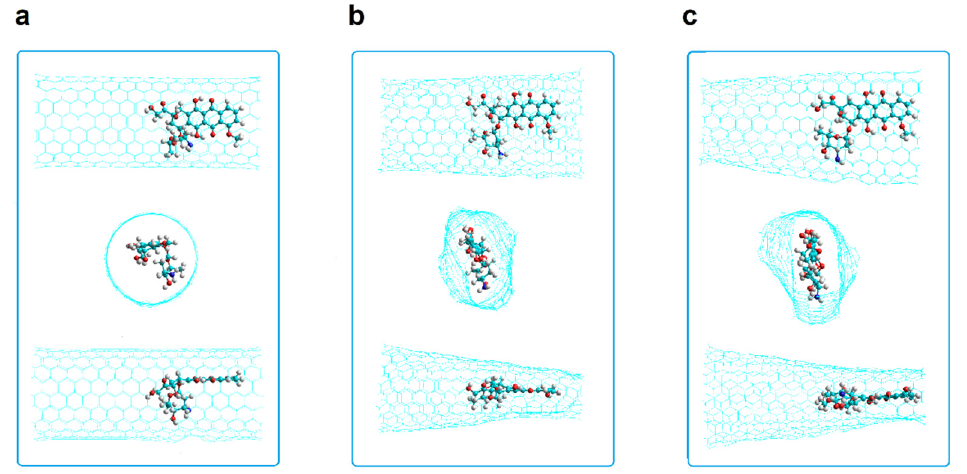
Figure 9. Representation of encapsulated DOX-CNT complex for undoped armchair nanotube with one Stone–Wales defect, A(10,10)0N-SW1-DoxDIn.v1 at different molecular dynamics simulation